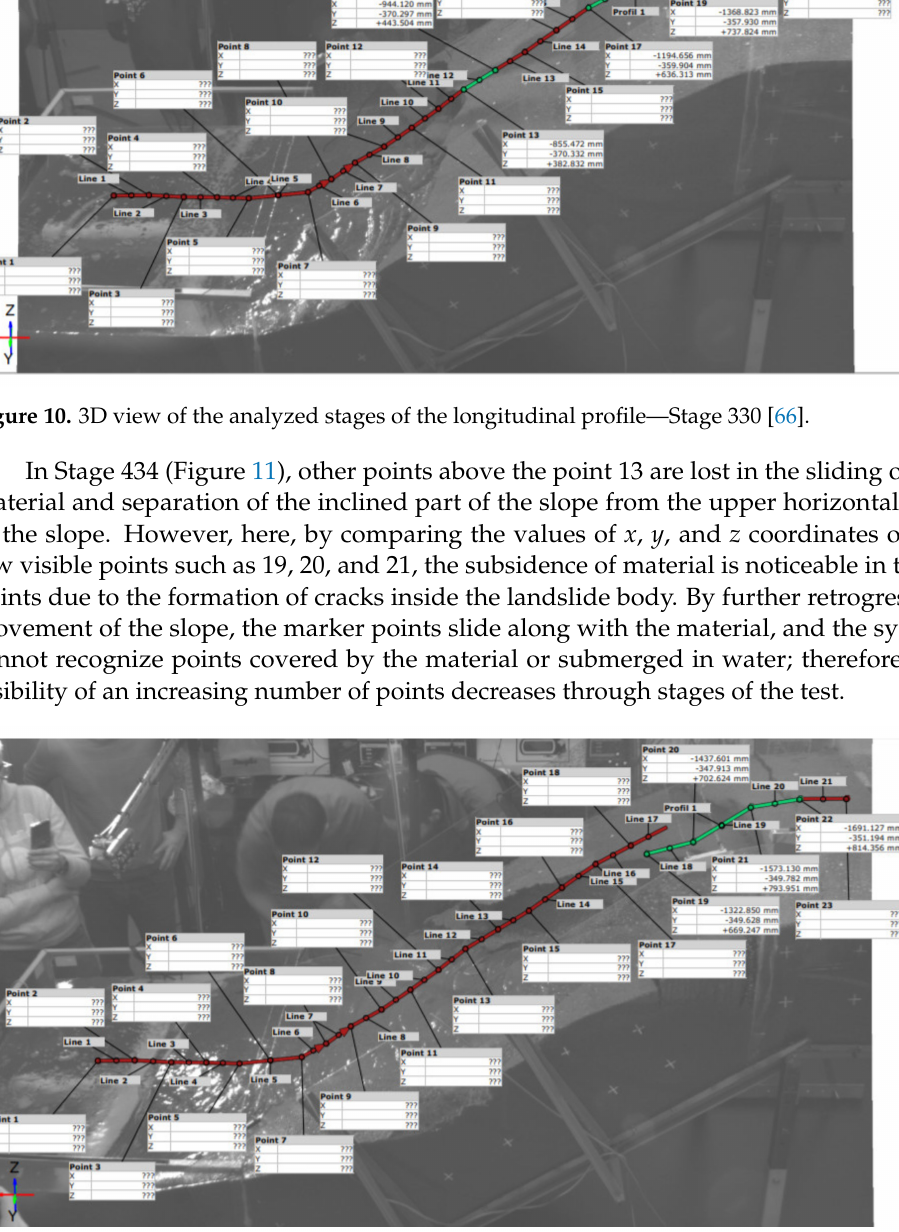
Figure 11. 3D view of the analyzed stages of the longitudinal profile—Stage 434